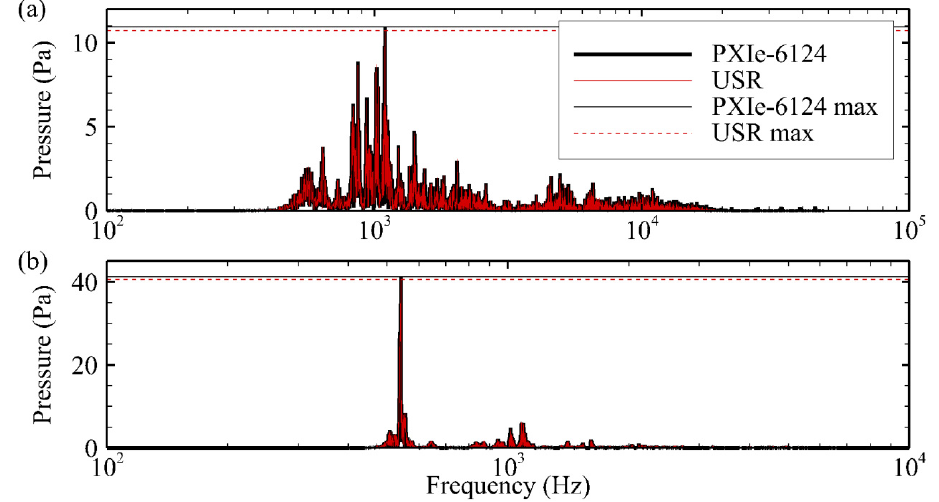
Figure 10. Sample spectrum comparisons from the tank testing. ( a ) Underwater explosion; ( b ) whale call.